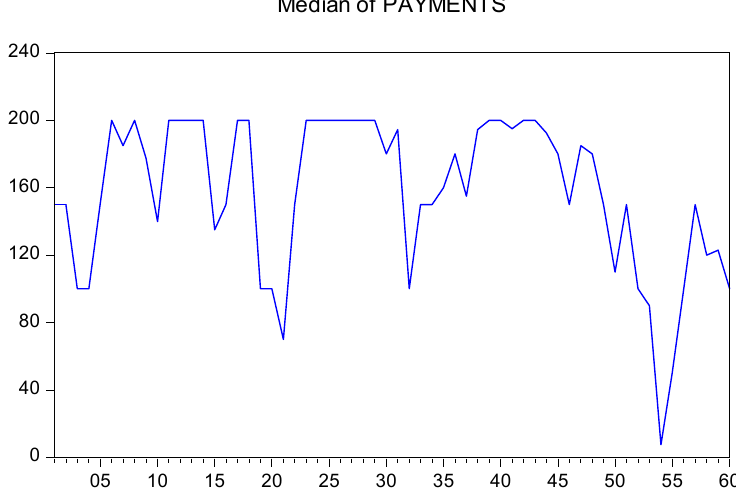
Figure 8. Median tax payments rounds 1 to 60 of all participants. Source: Own calculations.